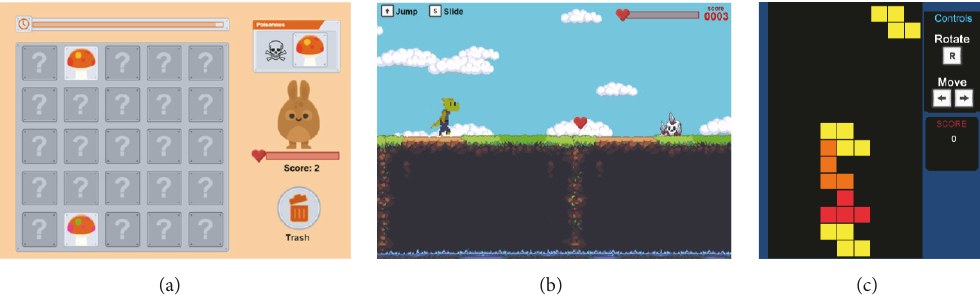
Figure 3: Games used in the experiment. From (a) to (c): Mushroom, where the player must sort bad from good mushrooms by analyzing color patterns; Platformer, where the player must jump over or slide below obstacles while collecting hearts; Tetris, which is a clone of the original version of the game, however without hints about the next piece to enter the